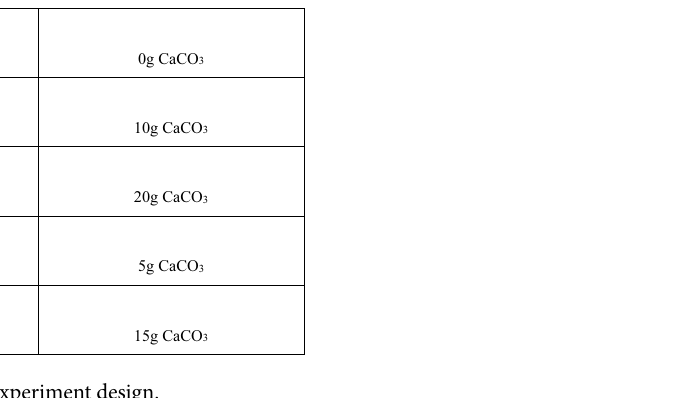
Figure 2. The split plot experiment